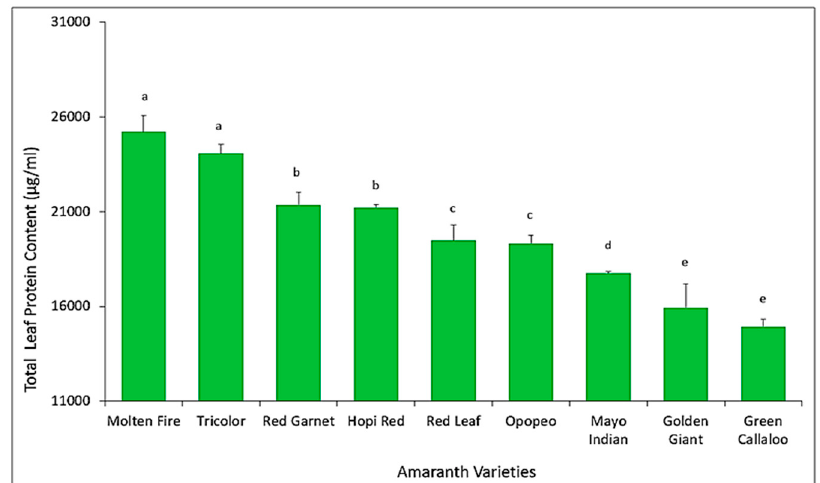
Figure 7. Total leaf protein content (Mean ± SE) among amaranth varieties. Bars with the same letters are not significantly different using Fisher’s LSD ( p < 0.05).